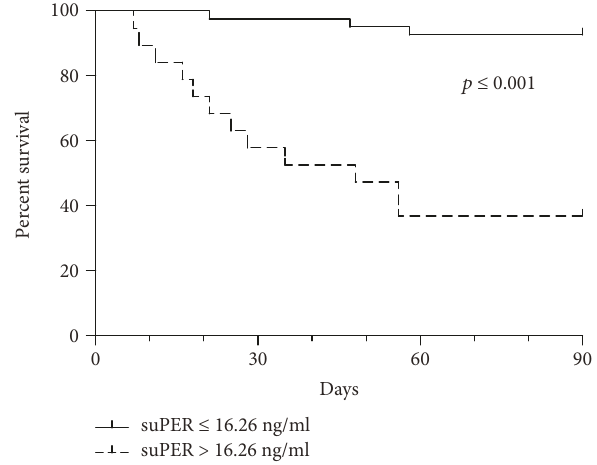
Figure 4: Three-month survival probability curves of hepatitis B- related ACLF patients included in the training set according to suPAR strati fi cation. Survival curves of patients classi fi ed according to the strati fi cation of systemic suPAR level with a cut- o ff of 16.26ng/ml during hospital stay. p ≤ 0 001 is obtained by the log-rank test within the two de fi ned